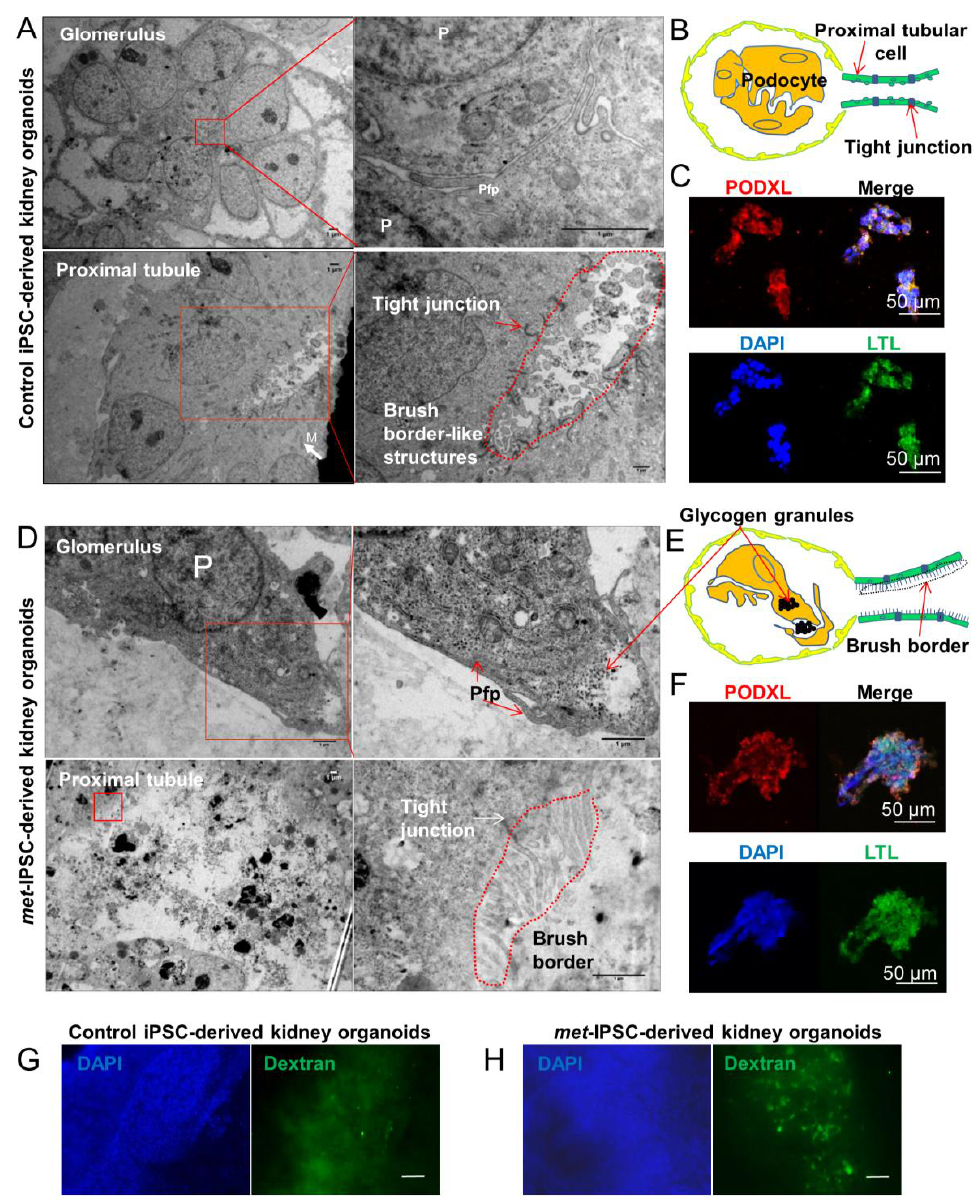
Figure 2. Ultrastructure and immunohistochemistry analyses by confocal microscopy. ( A – C ) Representative electron microscopy images of glomeruli and tubules of control and met -IPSC-derived embryoid bodies (EBs) showing podocyte-like cells (P), podocyte-like foot process (Pfp), mitochondria (M) and brush borders. The immunohistochemistry analysis in para ffi n cuts reveals both PODXL and LTL positivity in embryoid bodies. Scale bar: 50 µ m. ( D – F ) Representative electron microscopy images glomeruli and tubules of met -IPSC-derived kidney embryoid bodies revealing podocyte-like cells (P), podocyte-like foot process (Pfp), tight junctions, and typical brush border structures. Immunohistochemistry analysis in para ffi n cuts by confocal imaging showed embryoid bodies structures co-expressing PODXL and LTL. Scale bar: 50 µ m. As compared to control iPSC-derived embryoid bodies, the presence of glycogen granules(*) were noted ( D ). ( G – H ) Evaluation of functional analysis of proximal tubules structures in kidney embryoid bodies by using Dextran uptake assays. Embryoid bodies were incubated for 48 h in the presence of Dextran–Alexa 488 followed by analysis using wide-field microscopy. Dextran uptake was seen in normal ( G ) as well as in met -IPSC-derived embryoid bodies ( H ) with a more intense uptake in the latter structures (see text). Scale bar: 100 µ